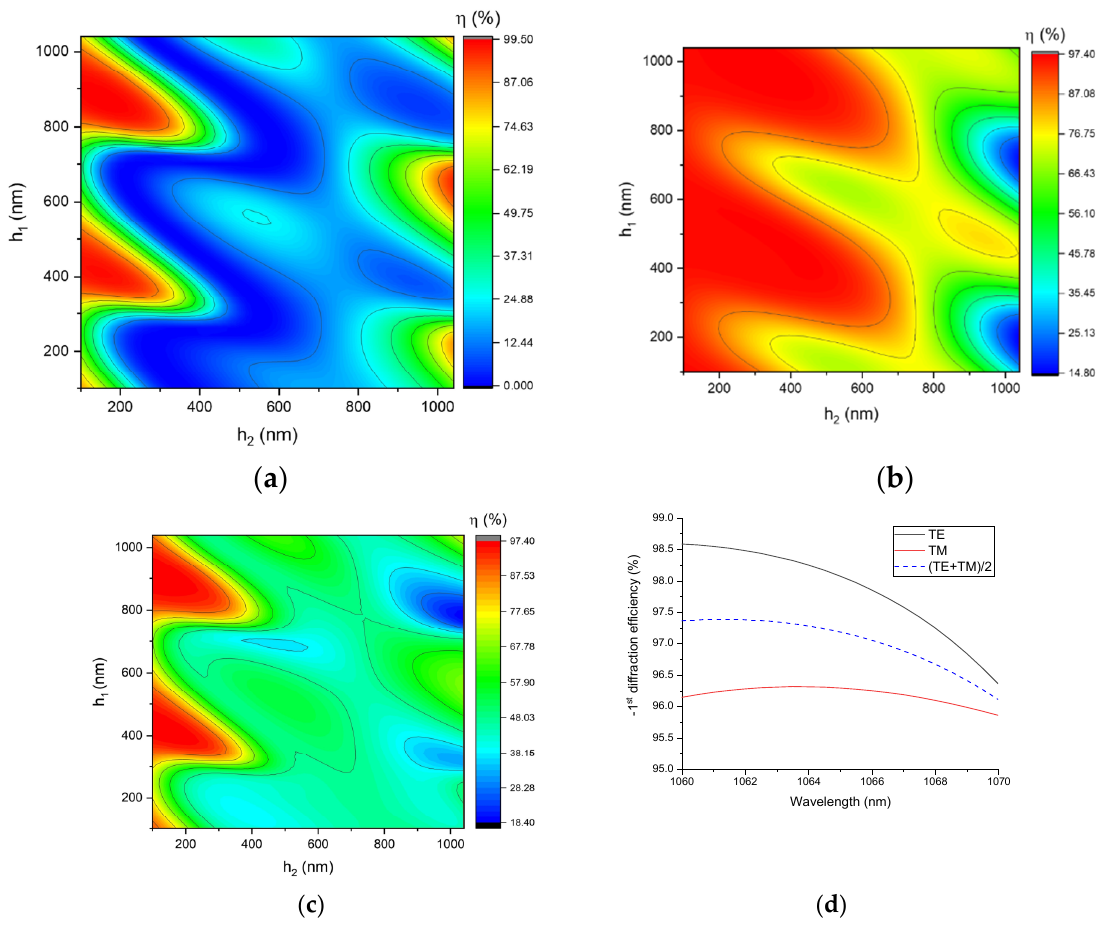
Figure 7. −1st diffraction efficiency of rectangular−shaped grating for ( a ) TE polarization and ( b ) TM polarization, ( c ) unpolarized light, and ( d ) diffraction efficiency of the optimum design.